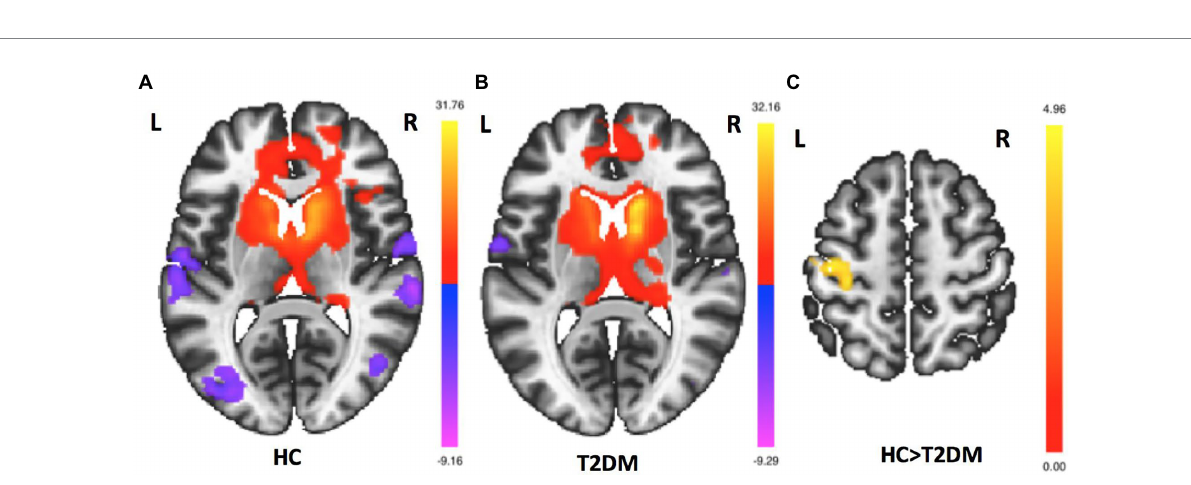
FIGURE 2 Group differences in right caudate FC maps. (A) . Right caudate FC maps for the HC group ( p < 0.05, FDR–corrected). (B) . Right caudate FC maps for the T2DM group ( p < 0.05, FDR–corrected). (C) Group differences in right caudate FC between the HC and T2DM groups in voxelwise whole- brain analysis. Compared to HCs, T2DM patients had reduced FC between the right caudate and left precentral gyrus ( p < 0.05, FWE